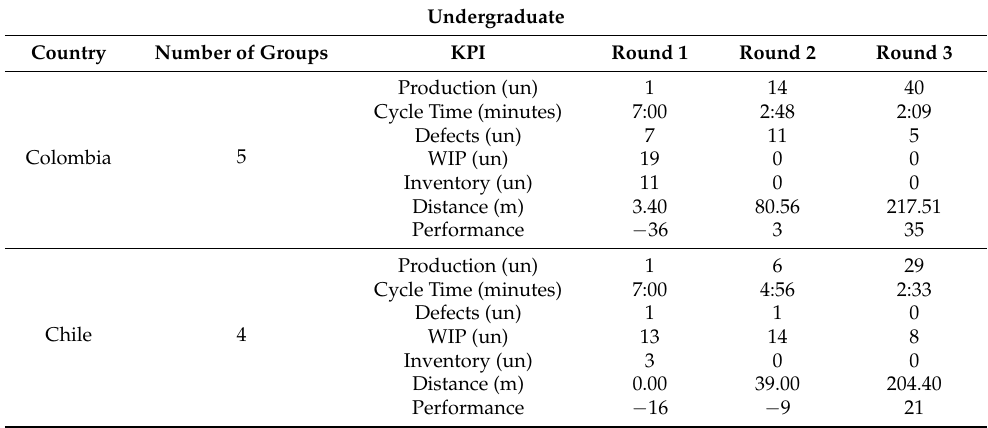
Table 7. Key performance indicators measured in the application of the game to undergraduate students.